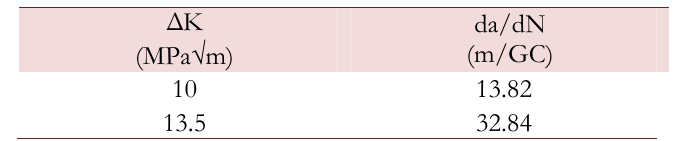
Table 8: Crack growth rates computed using the procedure IV.